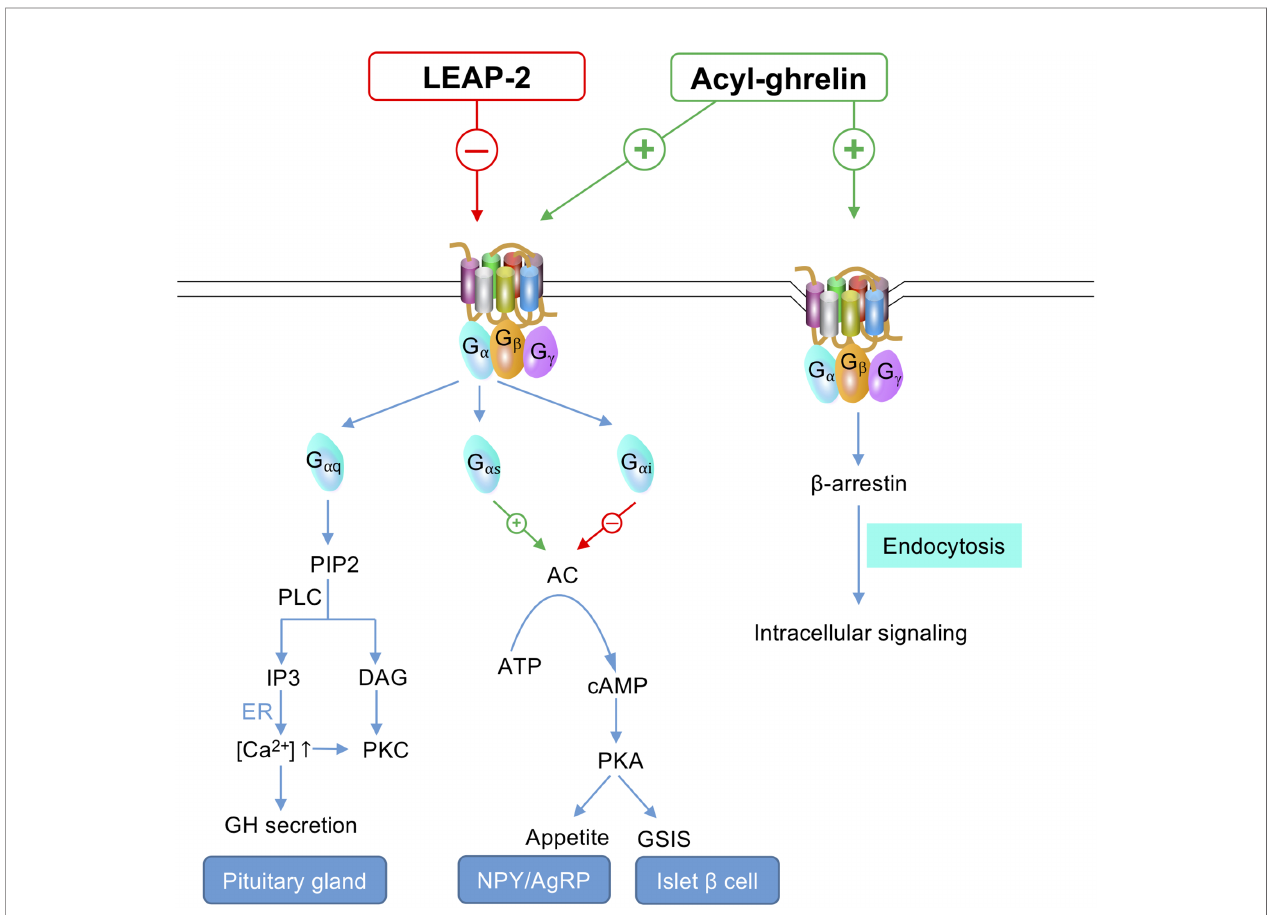
FIGURE 2 | GHS-R1a signaling under LEAP-2 suppression or ghrelin stimulation. G a q – PLC – IP3 cascade on pituitary gland is responsible for GH secretion. G a s – cAMP – PKA pathway on the NPY/AgRP neurons regulates appetite. G a i on islet b cells inhibits cAMP – PKA signaling and subsequently prohibits GSIS. Ghrelin initiates GHS-R1a endocytosis through the activity of b -arrestin, which facilitates intracellular signaling, whereas LEAP-2 binding does not lead to receptor internalization. -, inhibit; +, activate; ↑ , increase; PIP2, phosphatidylinositol 4,5-bishosphate; PLC, phospholipase C; IP3, inositol (1,4,5) triphosphate; DAG, diacylgycerol; ER, endoplasmic reticulum; [Ca 2+ ], Ca 2+ concentration; GH, growth hormone; PKC, protein kinase C; AC, adenylyl cyclase; ATP, adenosine triphosphate; cAMP, cyclic adenosine monophosphate; PKA, protein kinase A; GSIS, glucose-stimulated insulin secretion; NPY/AgRP, neuropeptide Y/agouti-related